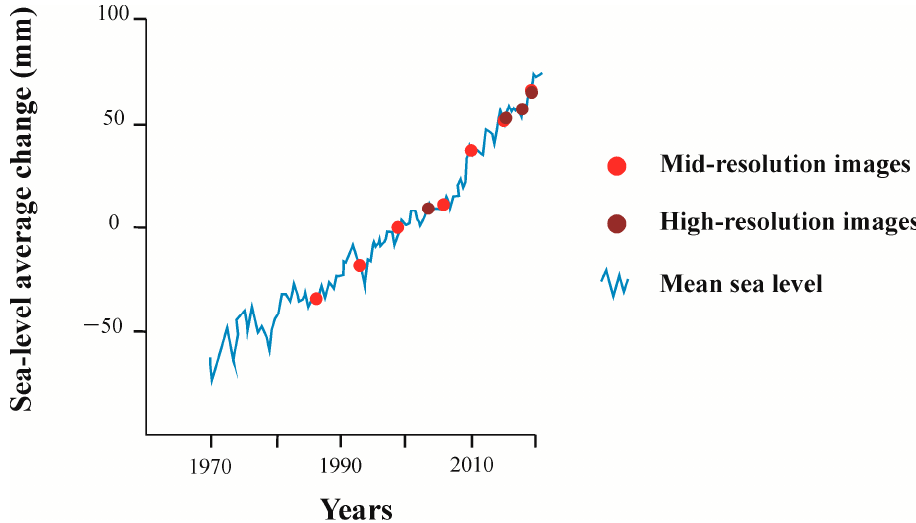
Figure 15. Mean sea-level fluctuations between 1970 and 2020 with satellite imagery acquisition dates (points) from this study. Modified from Lindsey [83].